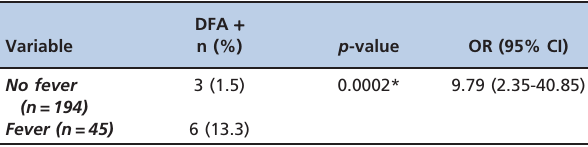
Table 2 - Univariate logistic regression analysis of the association between the presence of fever and positivity by DFA in KT patients.